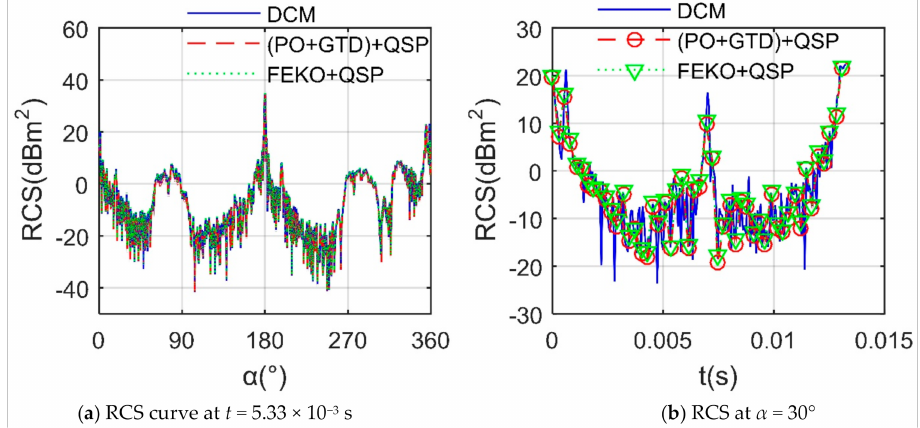
Figure 2. Verification of DCM on rotor 1, β = 0 ◦ , f rh = 10 GHz, n r1 = 1500 r/min, A c1 =0 ◦ . ( a ) RCS curves at t = 5.33 × 10 − 3 s. ( b ) RCS curves at α = 30 ◦ .